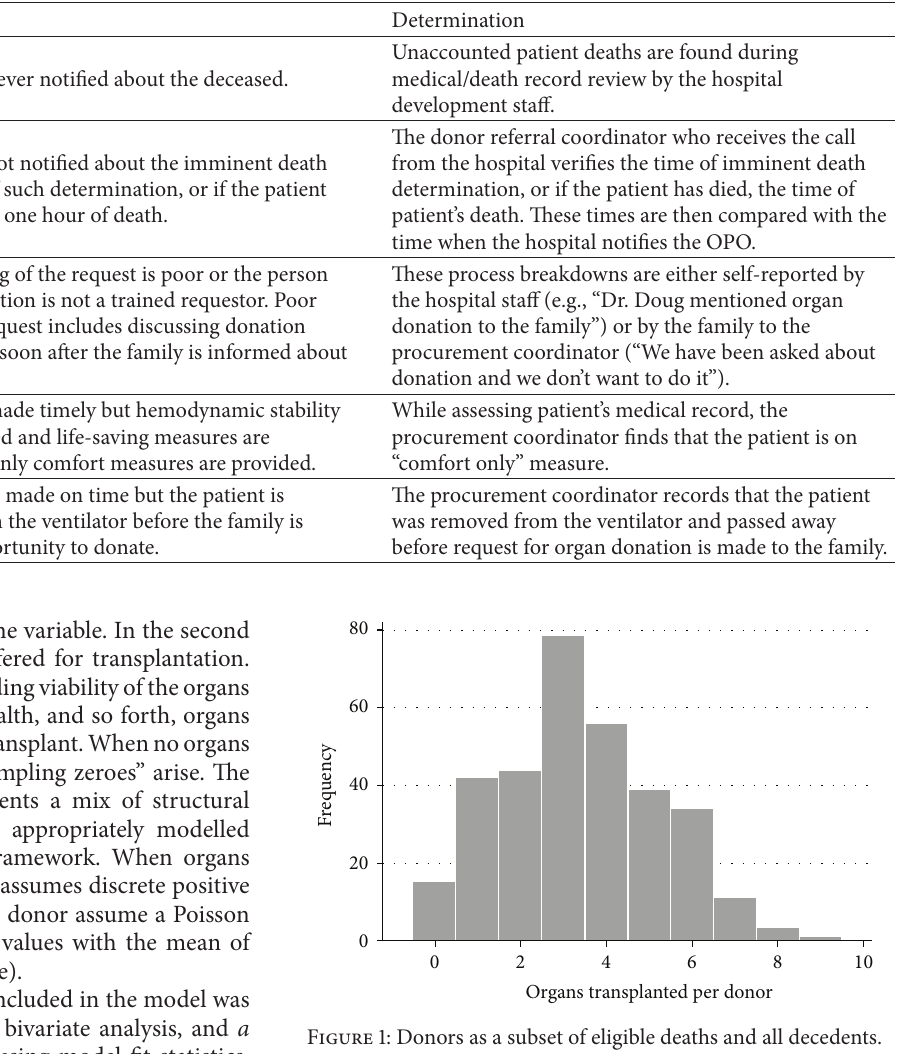
Figure 1: Donors as a subset of eligible deaths and all